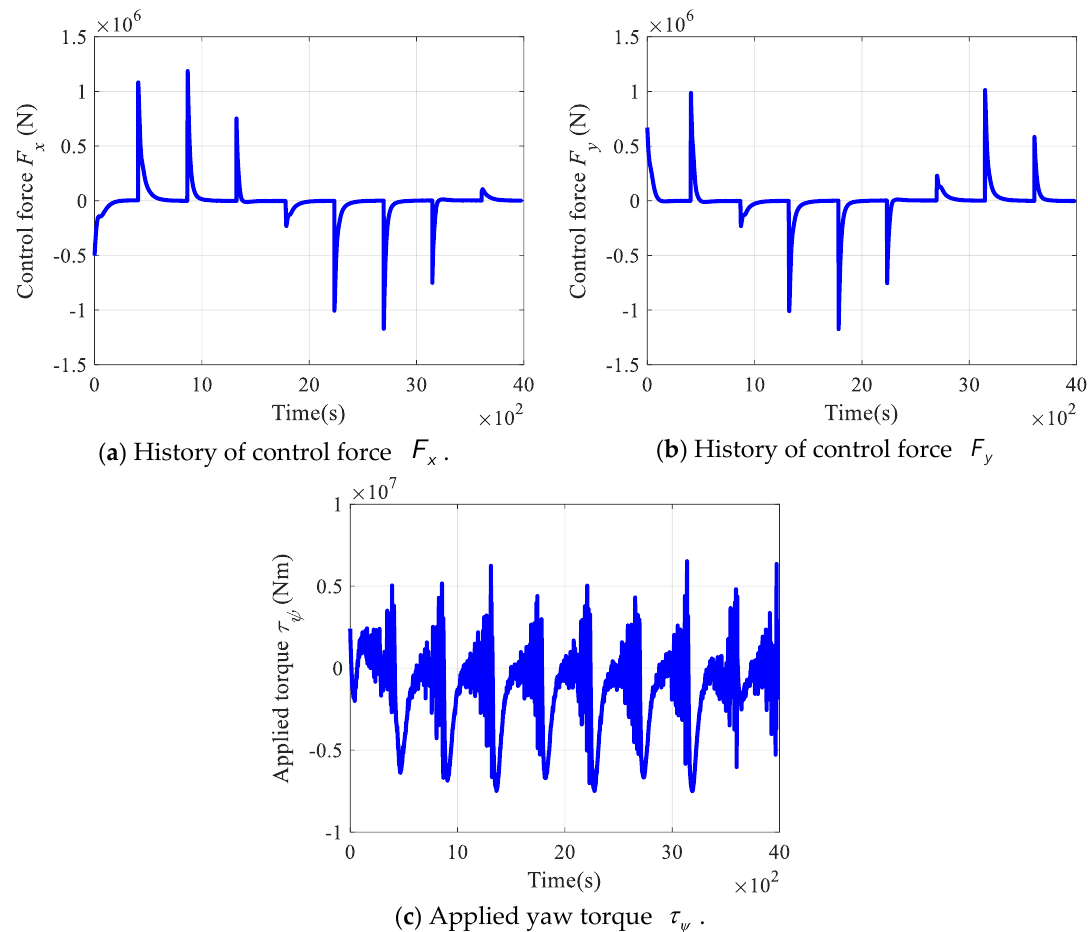
Figure 9. Control commands of controlled AUSV.